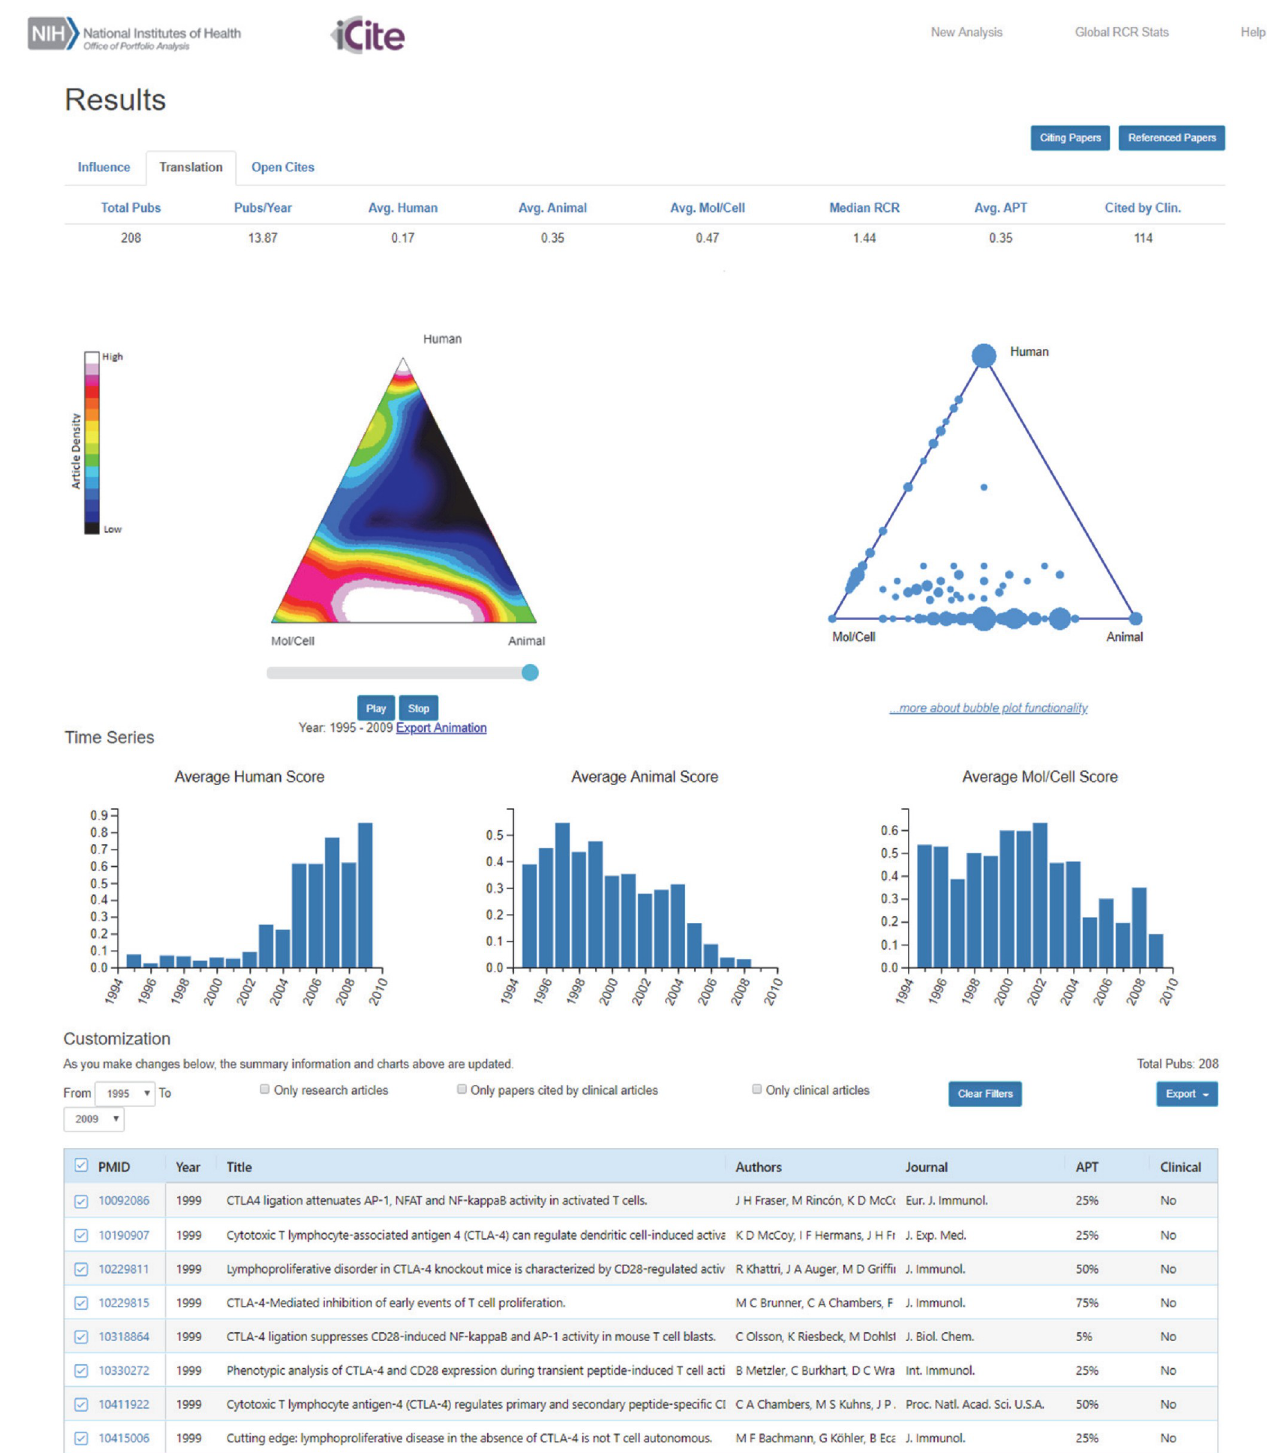
Fig 5. Screenshot of the translation module of iCite . Following standard PubMed-like searches to identify publications of interest, this new tool displays summary statistics (top) that include APT scores and the average fraction of HAMC MeSH terms, interactive trilinear graphs (middle) that include a heat map of the distribution of those publications within the triangle of biomedicine, and an interactive table (bottom) that displays the characteristics of each paper. The iCite tool is publicly available at https://icite.od.nih.gov/analysis. APT, Approximate Potential to Translate; HAMC, Human, Animal, and Molecular/Cellular; MeSH, Medical Subject Headings; Mol/Cell, Molecular/Cellular; RCR, Relative Citation Ratio.